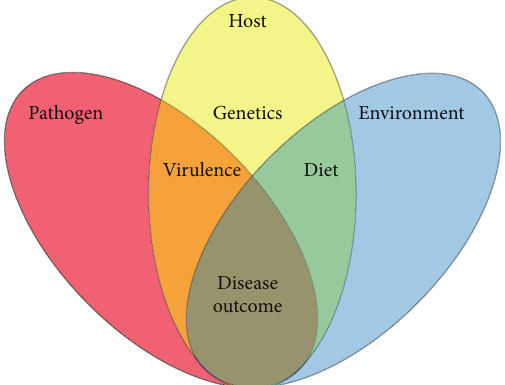
Figure 1: Model of factors influencing H. pylori -related disease outcome. Host genetics, environmental factors, and bacterial strain differences in virulence properties can all contribute to disease progression and increased risk of negative